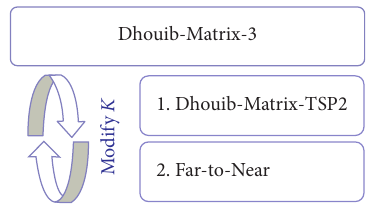
Figure 1: The proposed metaheuristic DM3.